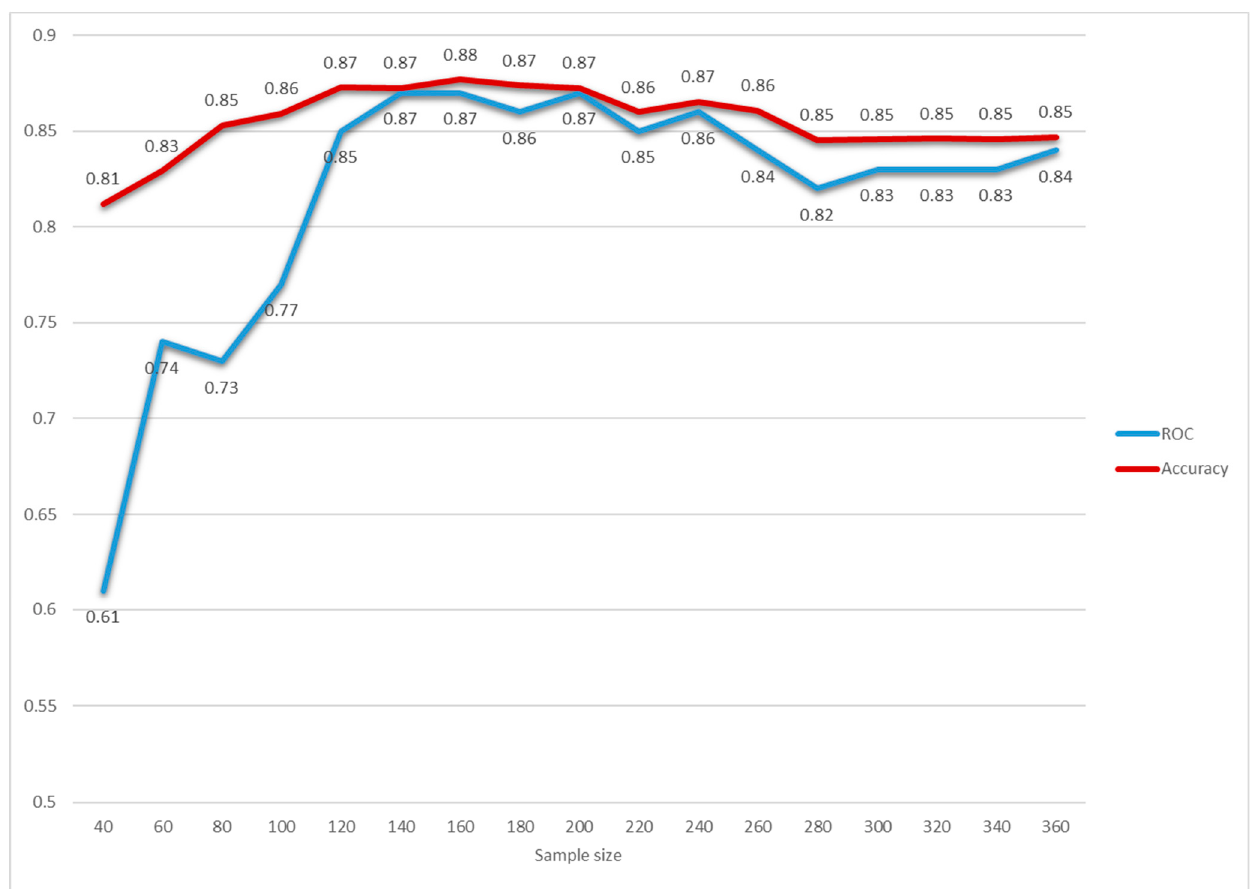
Figure 3. Random Forest’s ROC and accuracy as the availability of the data increased. The database was ordered according to the hospitalization date. Random Forests were built on the first 40, 60, 80,100, 120, 140, 160, 180,200, 220, 240, 260, 280, 300, 320, and 340 hospitalized patients. The ROC (blue line) and accuracy (red line) measures were reported according to the different sample sizes. The performance was computed by tuning and developing the Random Forest tool for the cumulative fractions of the sample.